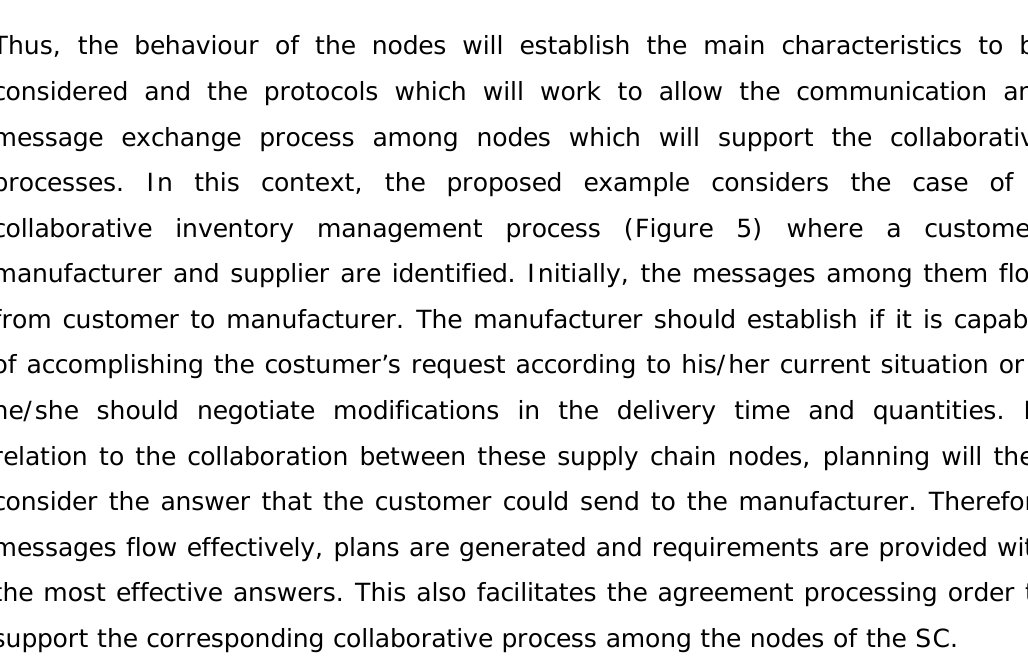
Figure 4. “Supply chain